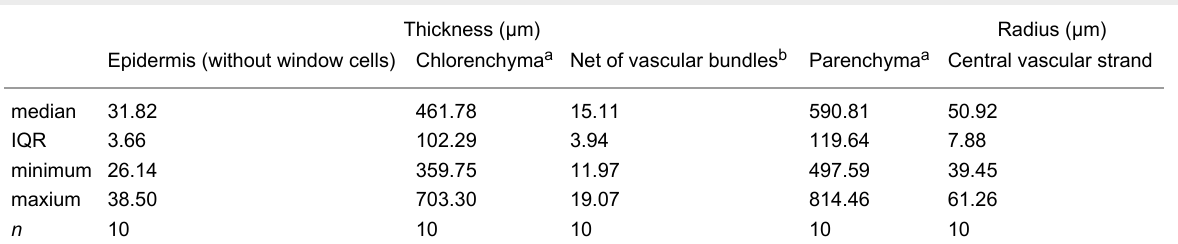
Table 1: Morphometric data of tissue layers found in adult leaves of Delosperma cooperi. Measurements derived from thin sections. IQR stands for interquartile